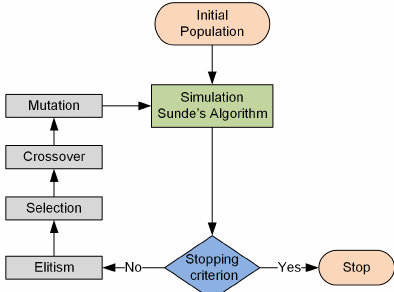
Figure 6. Genetic algorithm flowchart.